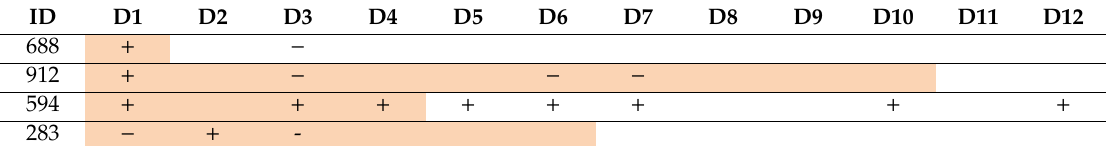
Table 4. Serial fechavirus results from cats tested on multiple dates.